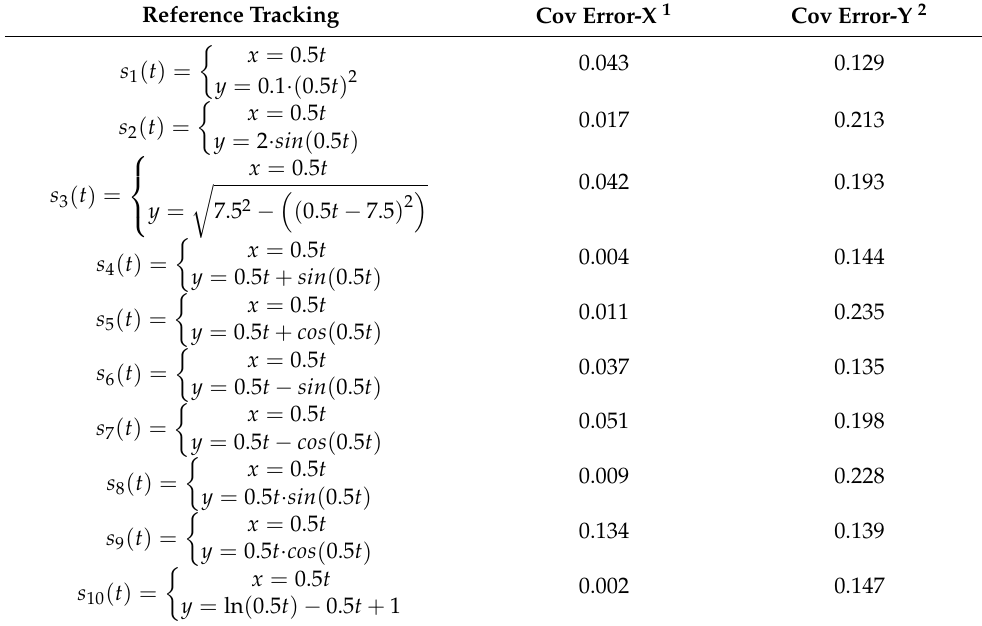
Table 2. Table of tracking error covariance in each